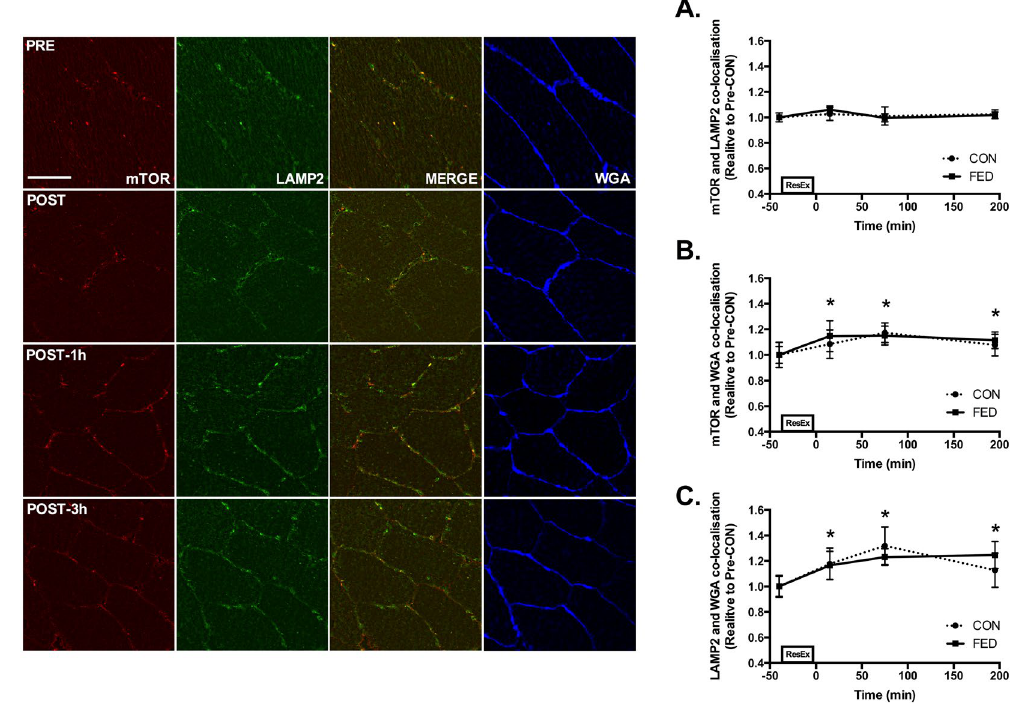
Figure 4. mTOR/LAMP2 complex translocation to the cell membrane following resistance exercise. Representative image of mTOR (Red), LAMP2 (Green), composite image of mTOR and LAMP2 (Merge) and WGA (Blue) for one subject from CON across the experimental time course. Yellow regions represent mTOR and LAMP2 interaction. Immunofluorescence quantification of mTOR and LAMP2 Co-localization ( A ), quantification of mTOR associated with the cell membrane marker WGA ( B ) and quantification of LAMP2 associated with WGA ( C ). Circles represent CON, squares represent FED. All image processing was kept constant between images, including exposure time, gain, and image frame. All data presented relative to the Pre exercise CON. Data presented as mean ± SEM (n = 7/group). * Significantly different to PRE-CON ( P <